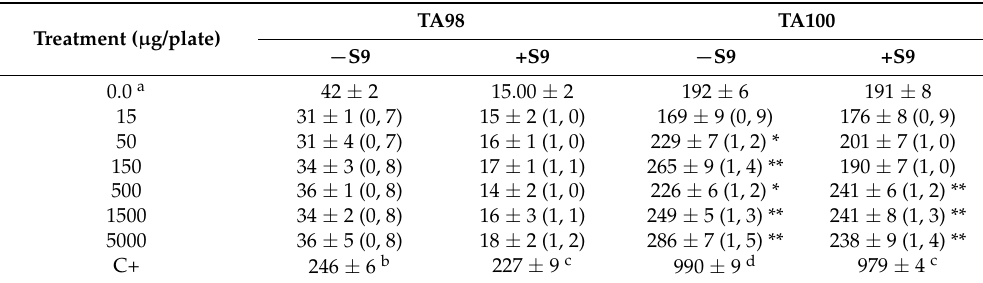
Table 3. Mutagenic activity expressed by the mean of revertant/plate index of mutagenicity (IM) of complex 1 [CuCl 2 (Bipy)(L 1 )] in the TA98 and TA100 strains of S. typhimurium in the presence (+S9) and absence ( − S9) of activation